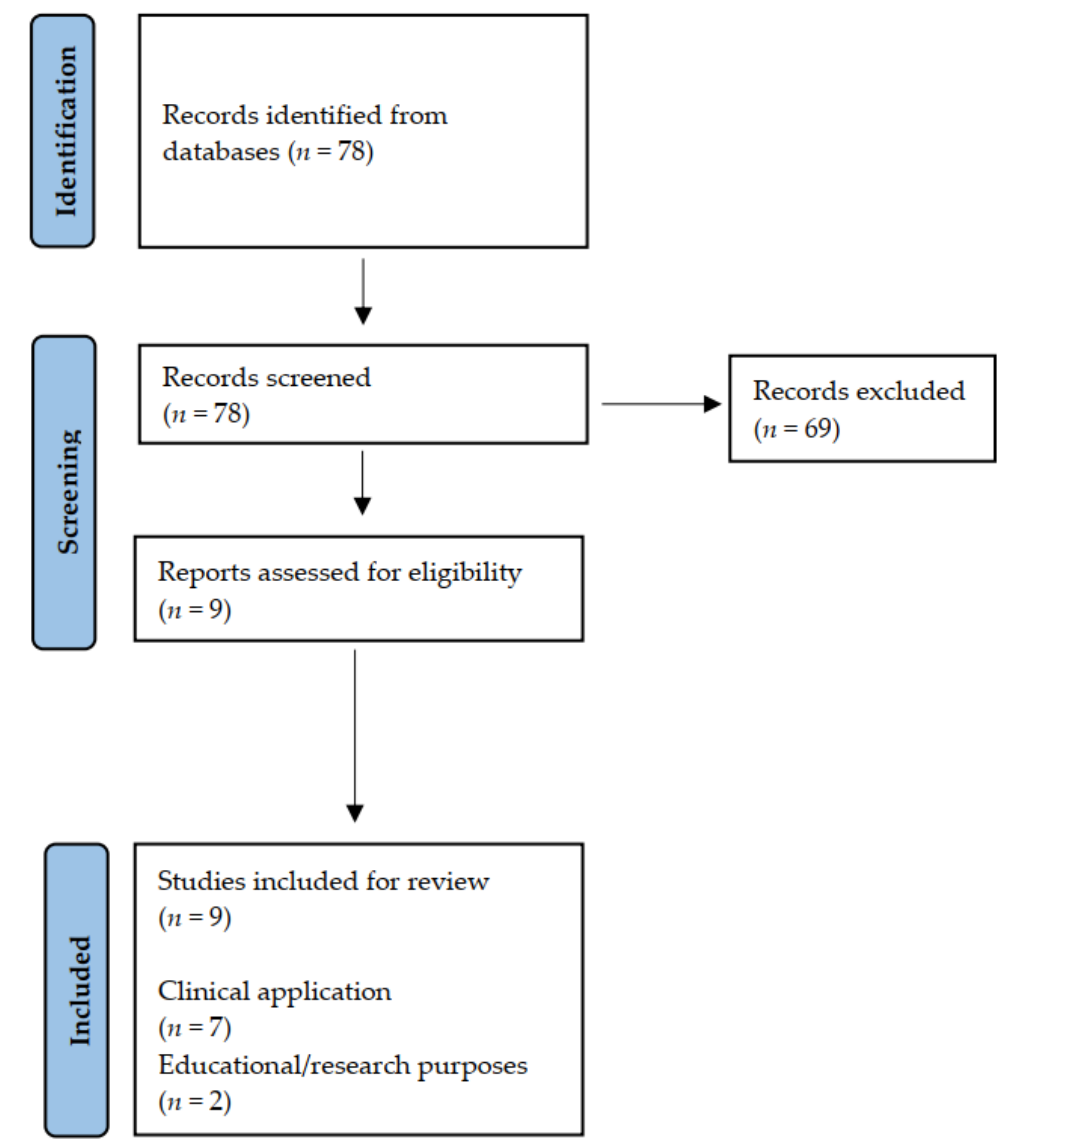
Figure 1. PRISMA flow